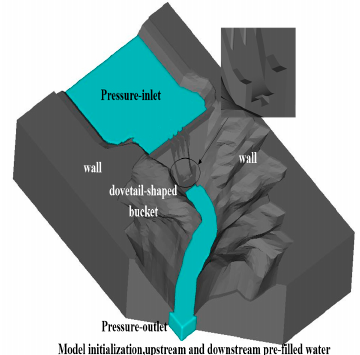
Figure 10. Specified boundary conditions for ShiZiYa reservoir.